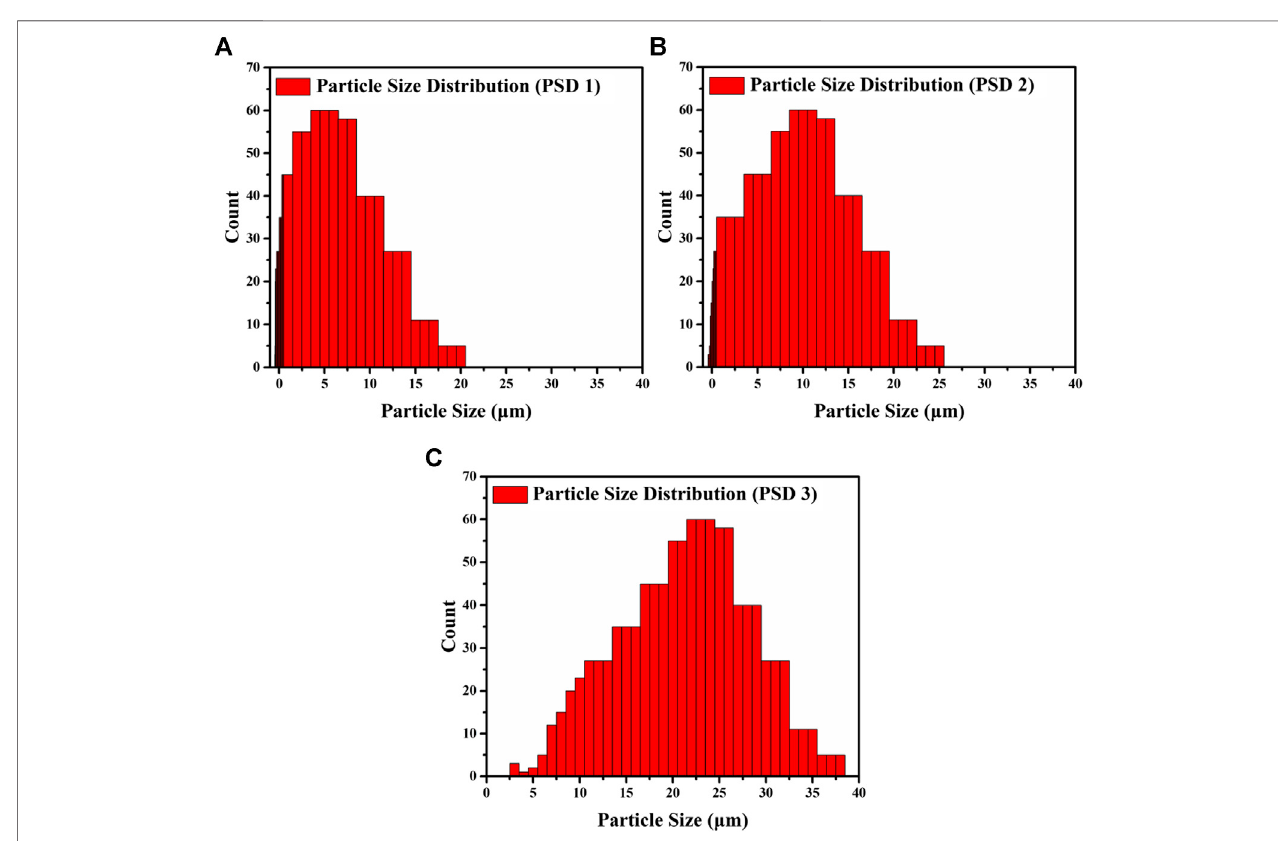
FIGURE 2 | Different particle size distribution of LDS particles in EVA fi lms (A – C)